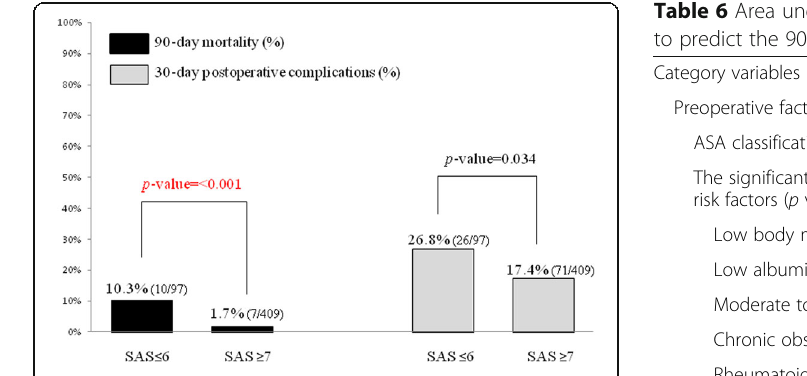
Fig. 1 The relationship between the SAS value and the 90-day mortality and 30-day postoperative complications. Patients were divided into two groups: the low-risk group (SAS ≥ 7) and high-risk group (SAS ≤ 6). Black bar : The 90-day mortality in each group. Gray bar : 30-day postoperative complications